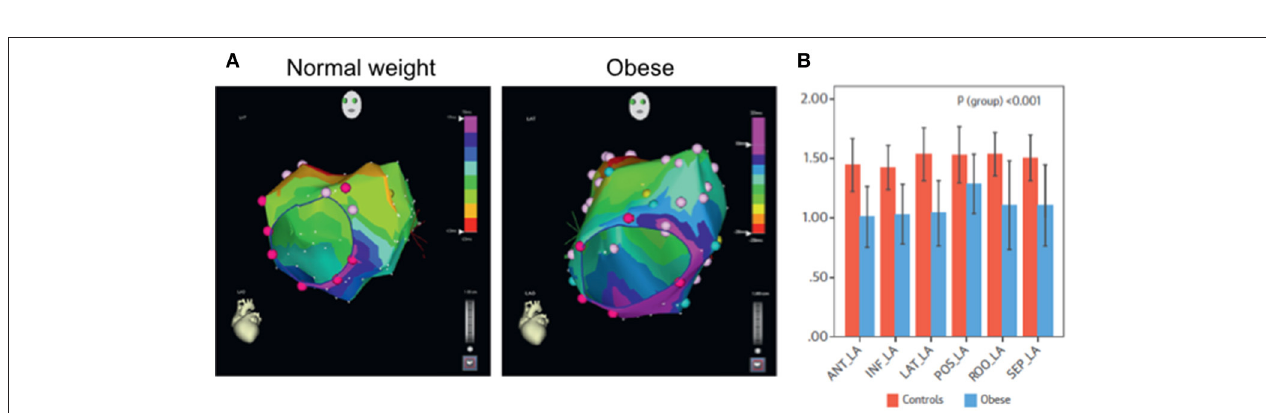
FIGURE 2 | Analyses of Impulse conduction in normal weight and in obese ovine (Measurements during sinus rhythm and isochrones from left anterior oblique view). (A) Representative 5ms isochronal maps. Note crowding of isochrones (i.e., slower propagation time) in the obese ovine, compared to the control. (B) Mean values of conduction velocity measured in the specified regions of the left atrium. Note that conduction velocity was reduced uniformly in all regions of the atrial myocardium. ANT, anterior; LA, left atrium; INF_LA, inferior left atrium; LAT_LA, lateral left atrium; POS_LA, posterior left atrium; ROO_LA, left atrial roof; SEP_LA, septal left atrium. Modified from Mahajan et al.